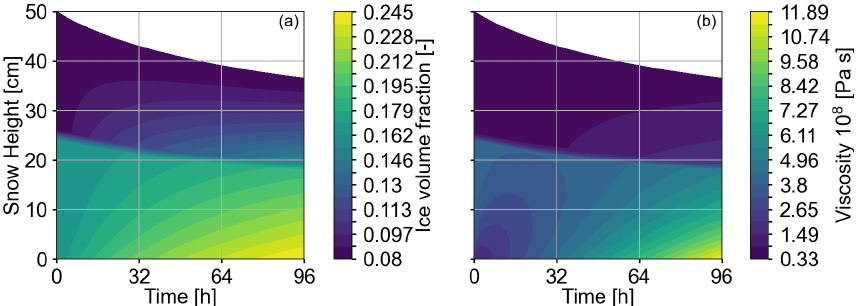
Figure 9. The plots show the evolution of the ice volume fraction (a) and viscosity (b) for 4d for Case 7 of Table 2, which refers to the fully coupled processes combined with a dynamically varying viscosity. Snow height is depicted on the y axis. The upper and lower layers are interpreted in both plots as the darker areas in the upper part and the lighter areas in the lower part. In (a) ice volume fraction increases most at the bottom of the upper layer. The lower layer consolidates less than the upper layer. In (b) viscosity increases more slowly in the upper layer and increases faster (by up to 1 order of magnitude) in the lower